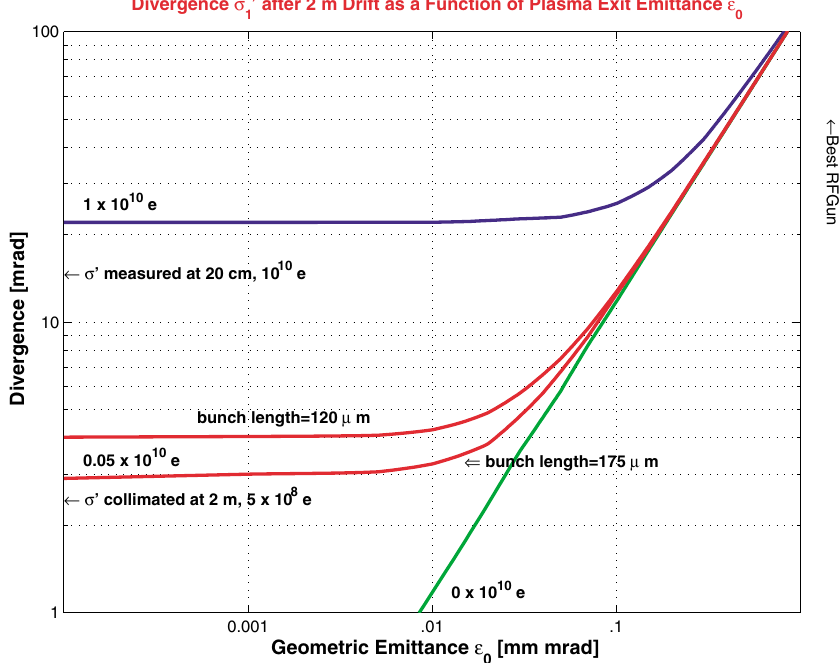
FIG. 3. (Color) Calculated divergence after 200 cm drift for charges N (cid:3) 0 (green), N (cid:3) 5 (cid:1) 10 8 (red), and N (cid:3) 10 (cid:1) 10 10 (blue) at an energy of 7 (cid:5) 3 MeV as a function of the . This calculation assumes a 400 fsec long laser pulse plasma exit emittance (cid:1) 0